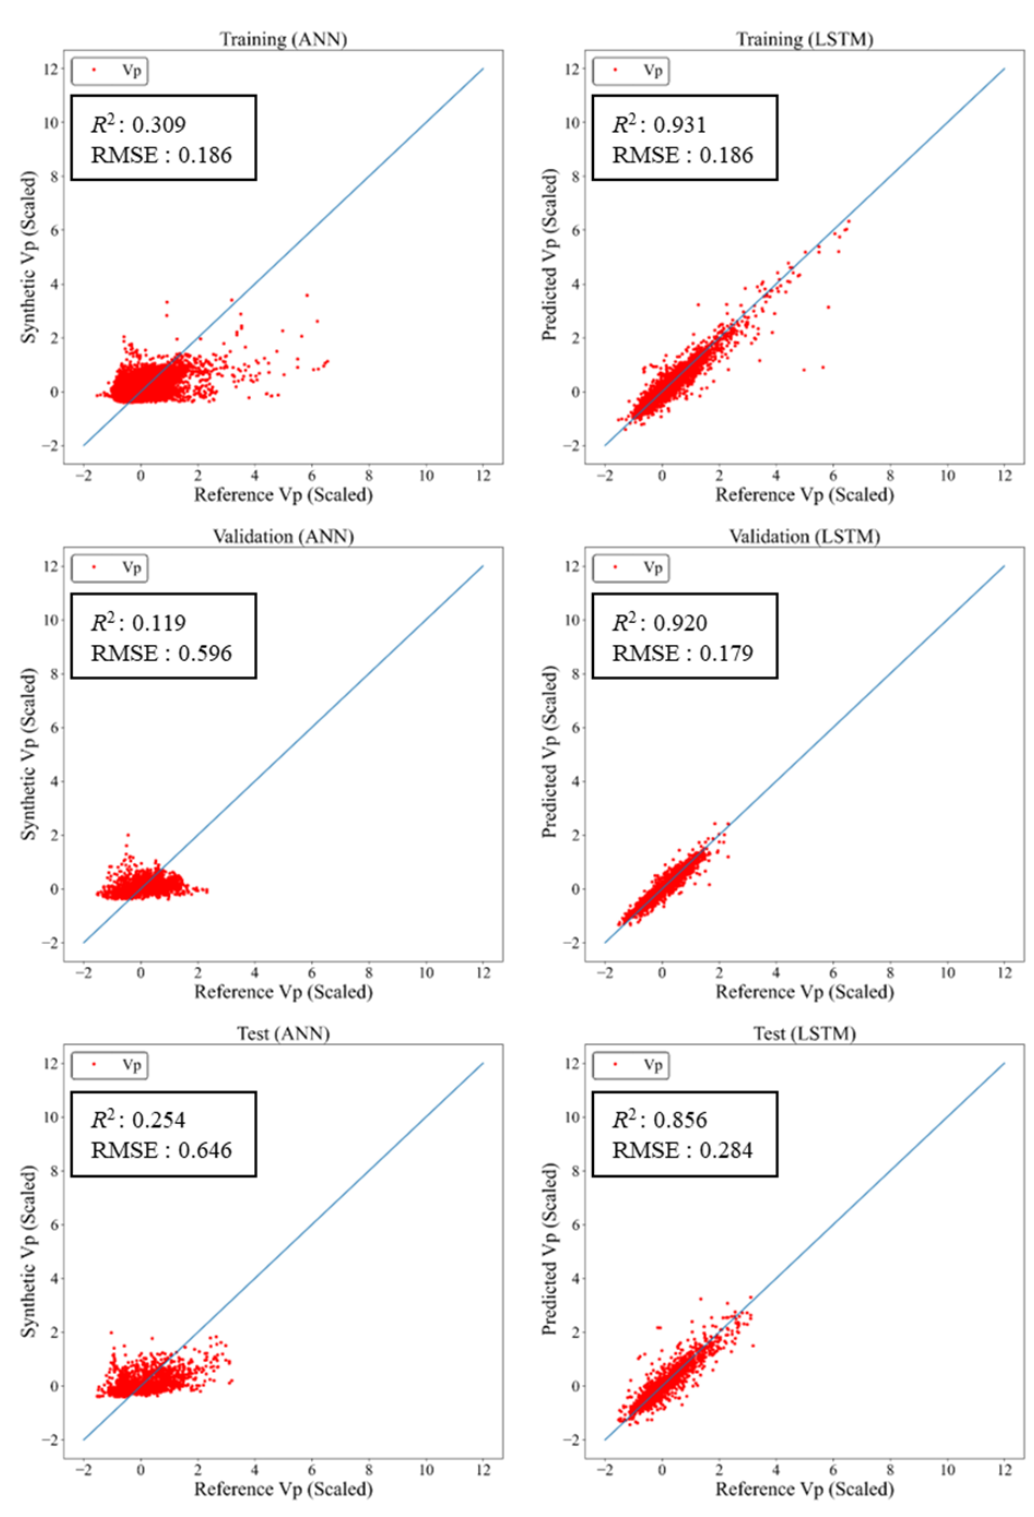
Figure 8. Scatter plots comparing the reference and predicted Vp data (scaled) for the training, val- idation, and test data for the ANN and LSTM (Fold 3). validation, and test data for the ANN and LSTM (Fold